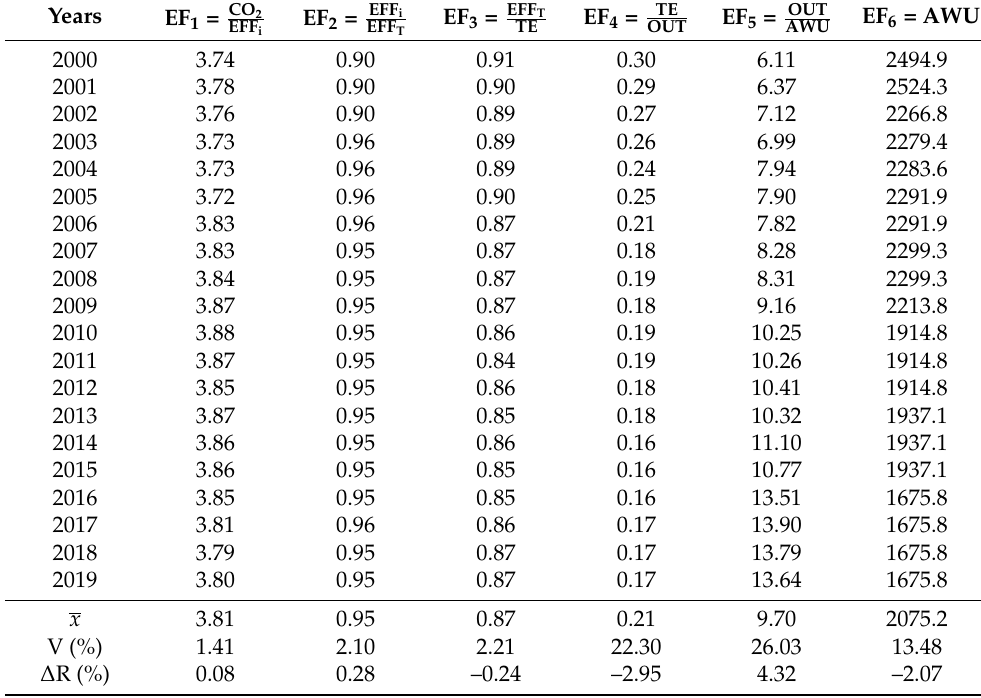
Table 3. Changes in the factors of the decomposition model for Polish agriculture in 2000–2019 1,2